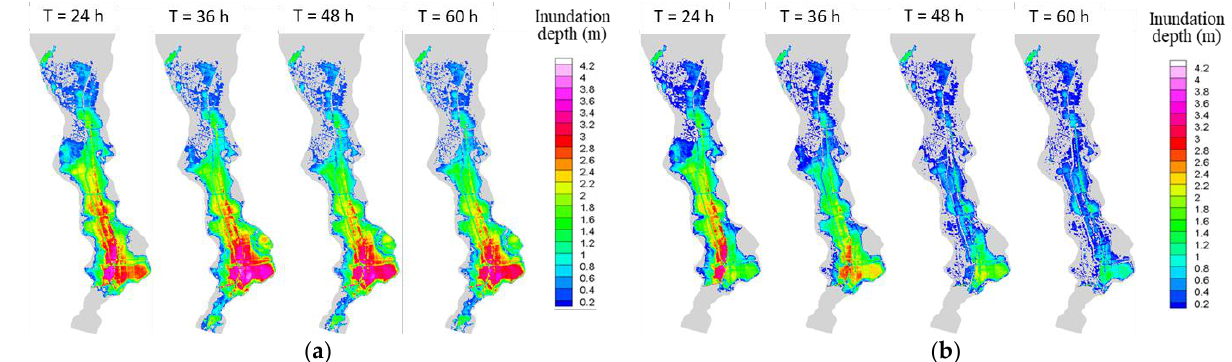
Figure 16. Variation in water depth distribution; ( a ) drainage by pump station (Case 1) and ( b ) drainage by inverted siphon (Case 2).